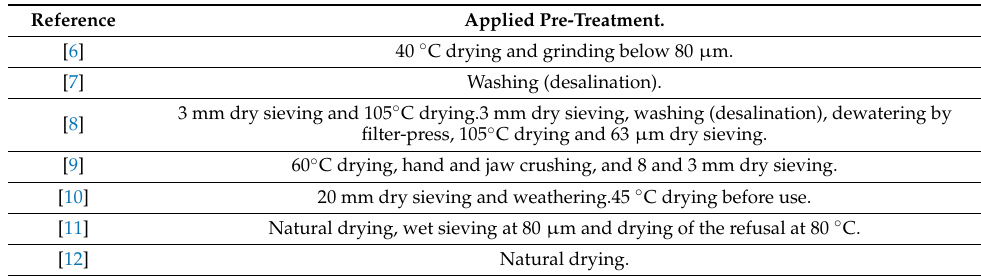
Table 12. Pre-treatment applied by several authors on sediment before incorporation into mortars or